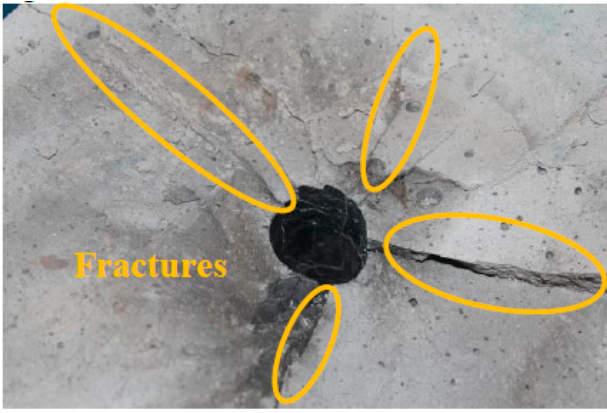
Figure 7. Characteristics of the oil shale fracture after pyrolysis.